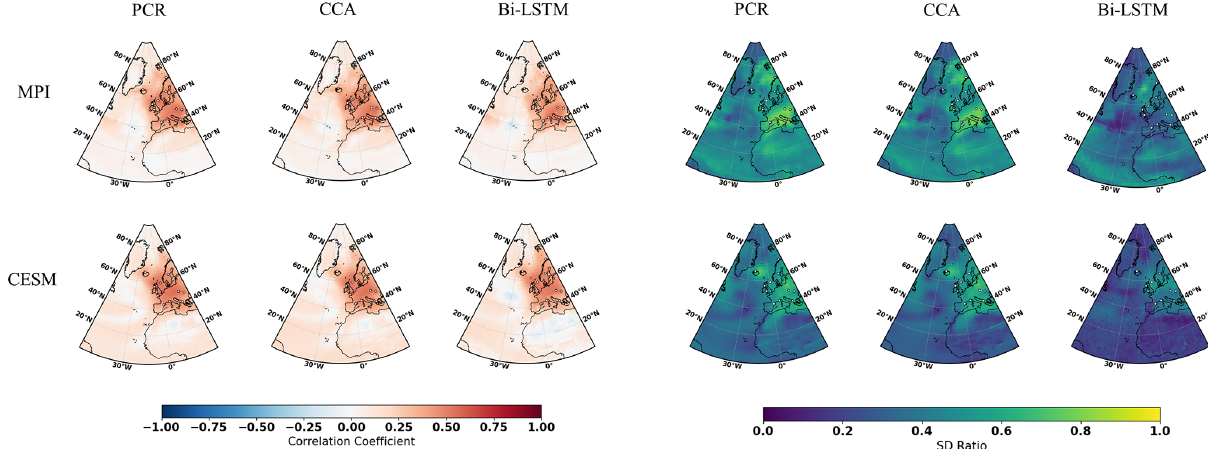
Figure 4. The same as Fig. 2 but for employing the full 11-pseudoproxy network with red noise contamination.